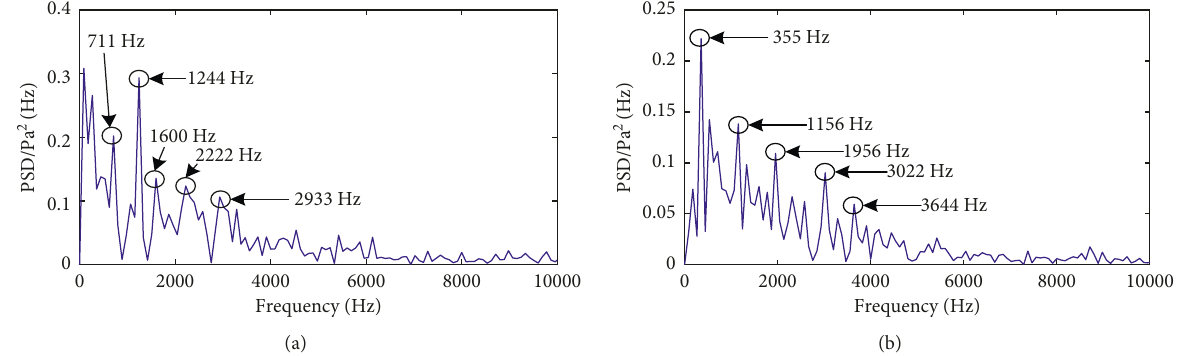
Figure 15: Mechanical noise. (a) 1500rpm and no-load condition and (b) 800rpm and no-load condition.